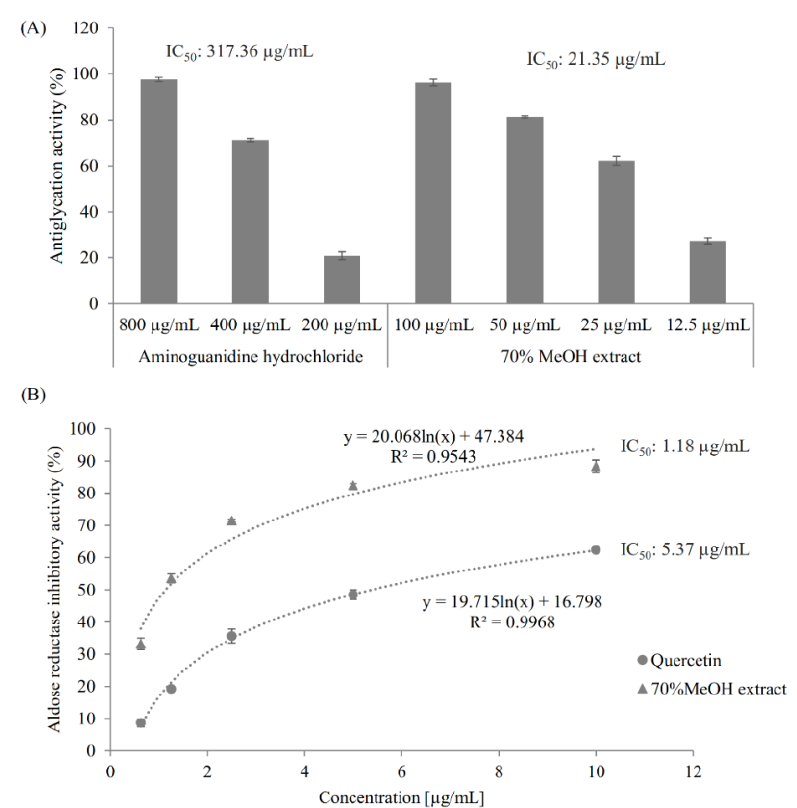
Figure 1. Antiglycation activity and aldose reductase inhibitory activity of the 70% methanol extract of M. volcanica . ( A ) Antiglycation activities of the the 70% methanol extract of M. volcanica (IC 50 , 21.35 µ g/mL) and its positive control aminoguanidine hydrochloride (IC 50 , 317.36 µ g/mL). ( B ) Aldose reductase inhibitory activities of the 70% methanol extract of M. volcanica (IC 50 , 1.18 µ g/mL) and its positive control quercetin (IC 50 , 5.37 µ